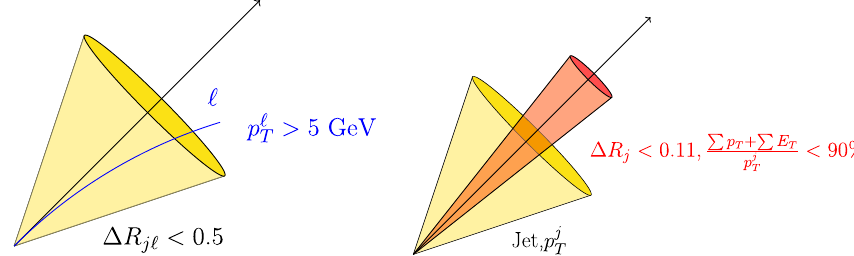
Fig. 3 Sketches to visualize the event selection conditions about the jet substructure listed in Table 1. The yellow cone stands for a jet in the arrow direction. The left panel shows that the hard lepton contained in the jet should satisfy the two conditions (cid:13) R j (cid:3) < 0 . 5 and p (cid:3)